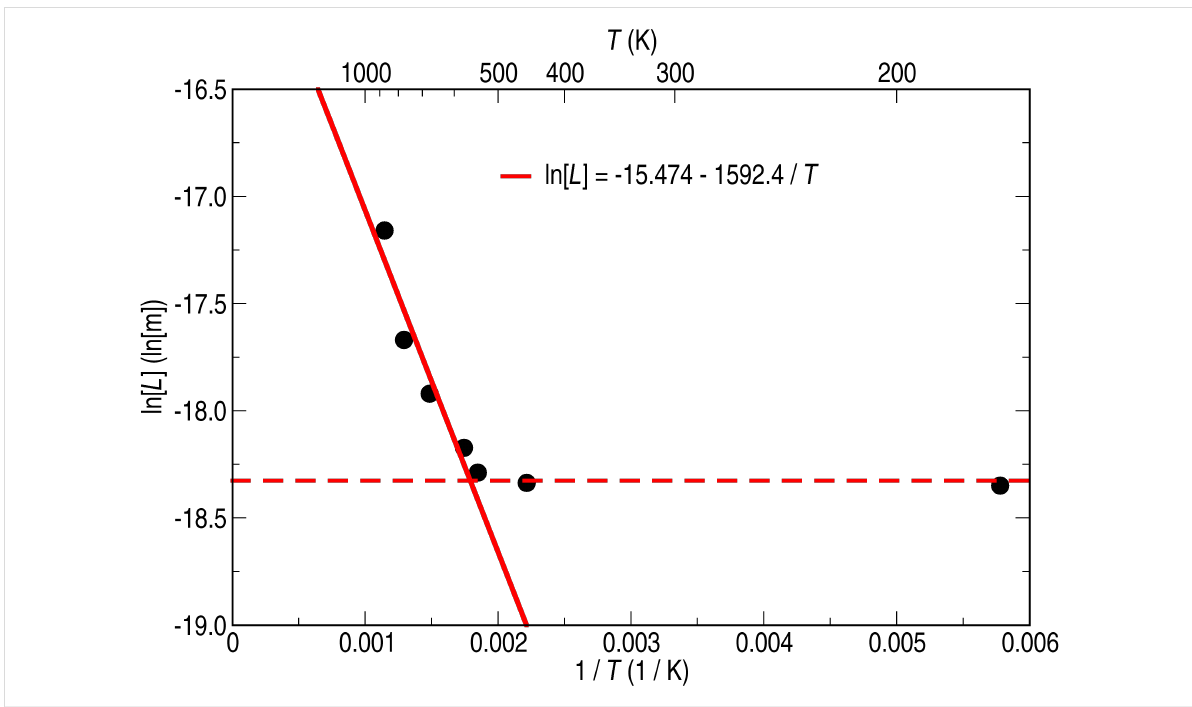
Figure 6: Arrhenius plot for analyzing the diffusion process of the Ni on HOPG. Two regimes are distinguishable in the graph and are emphasized with two linear fits to the data.